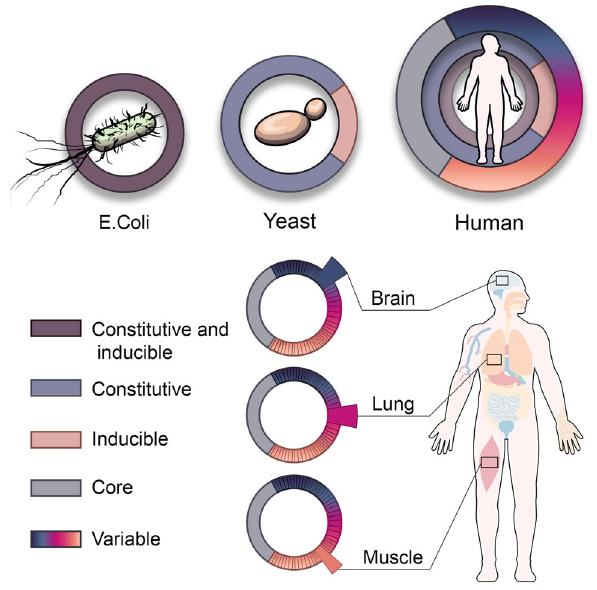
Fig. 7 A layered architecture of chaperones across unicellular and multicellular organisms. The chaperone system of E. coli is composed of constitutive chaperones that can be induced upon stress (left). The chaperones system in yeast diverged to include chaperones that are either constitutive or stress-induced (middle). In multi-cellular organisms such as human, the chaperone system diverged further to also include core chaperones that are stable across tissues and variable chaperones that are differentially expressed across tissues (right), thereby giving rise to tissue- speci fi c expression patterns, for example in brain, lung, or